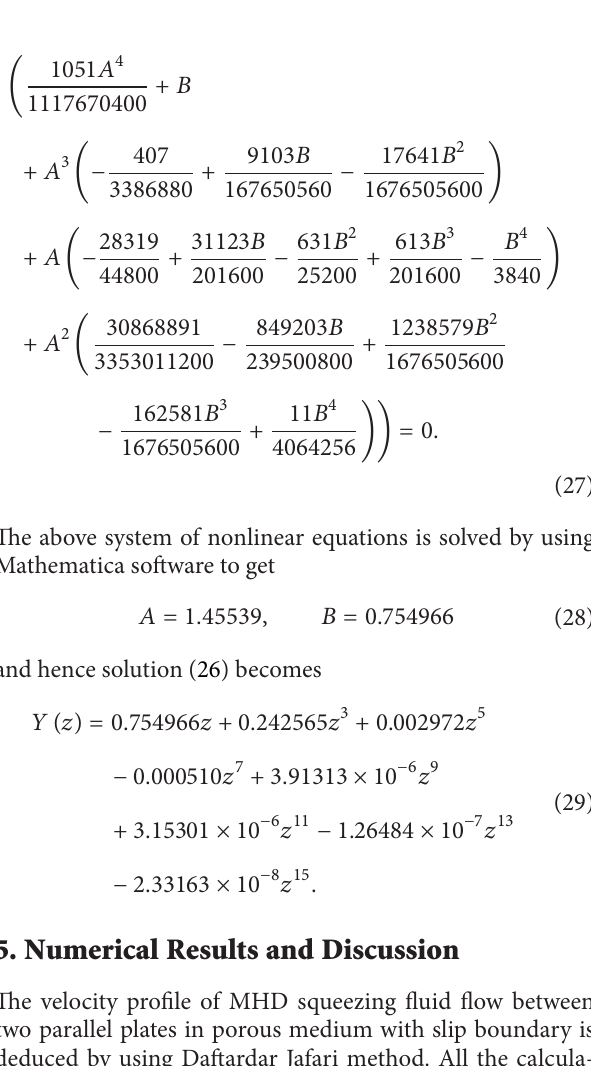
Figure 2: Velocity profile for different values of Reynold and Hartmann numbers with Re ≤ Me.